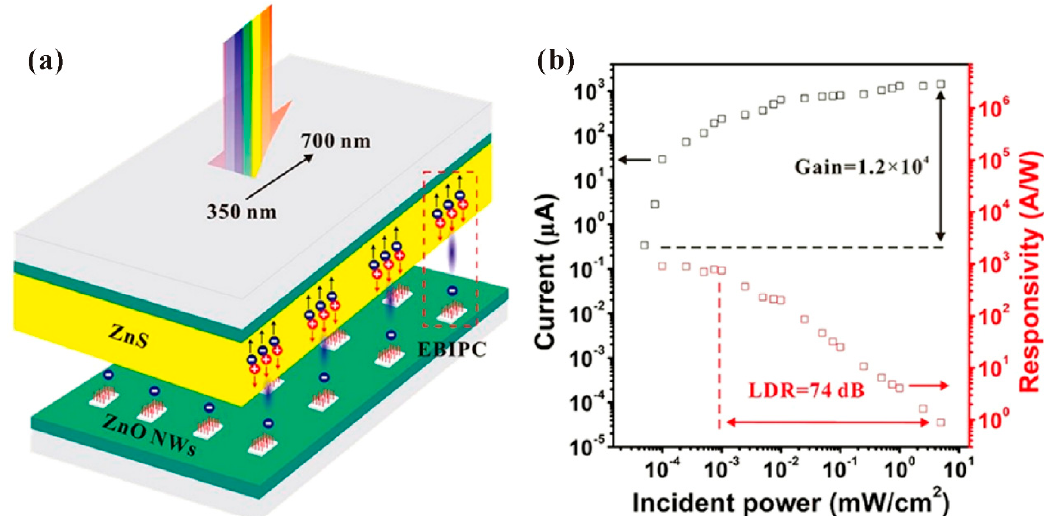
Figure 37. Demonstration of a photodetector based on a ZnO nanowire cold cathode. Schematic diagram ( a ) and perfor- mance ( b ) of the device. Reproduced from [112], with the permission of ACS Publications, 2018.